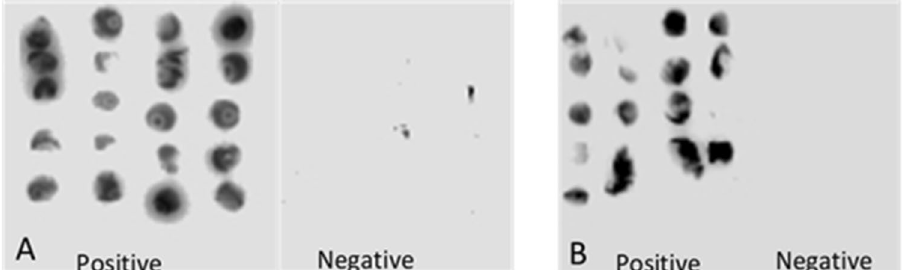
Figure 4. Dot blot assays of SCA ( A ) and immunoreactive protein band (10–12 kDa) ( B